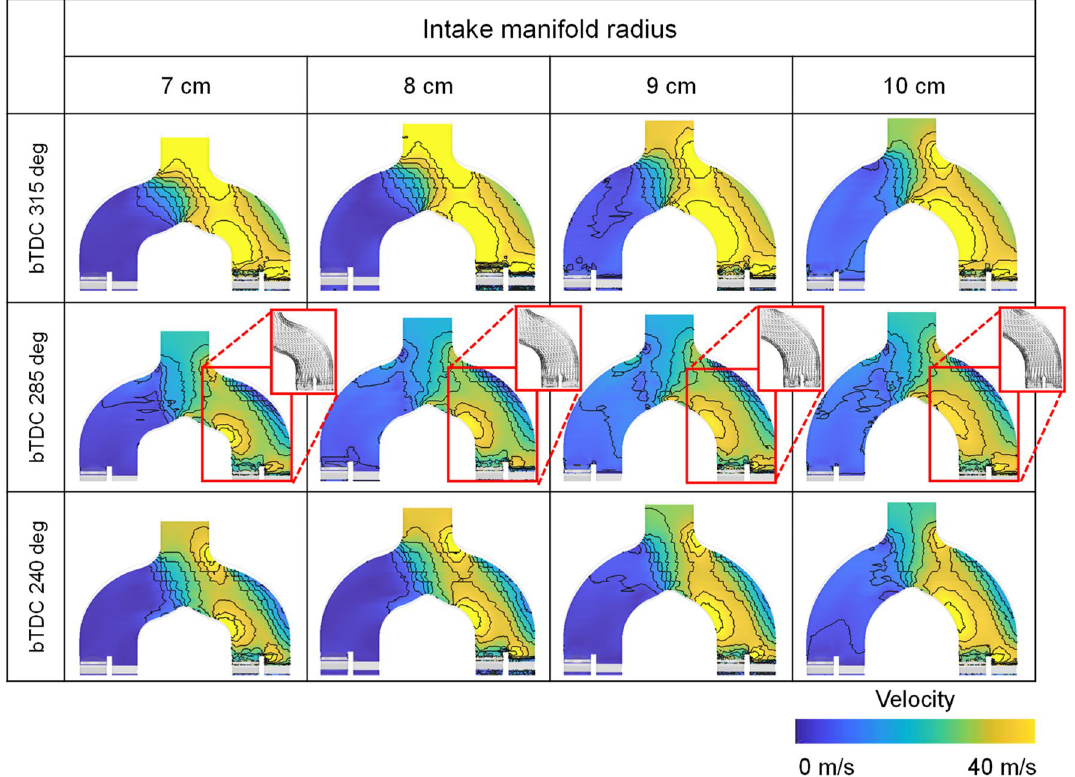
Figure 21. Velocity distribution at intake manifold during cylinder 1 intake process for different intake manifold curve radius at engine speed of 2000